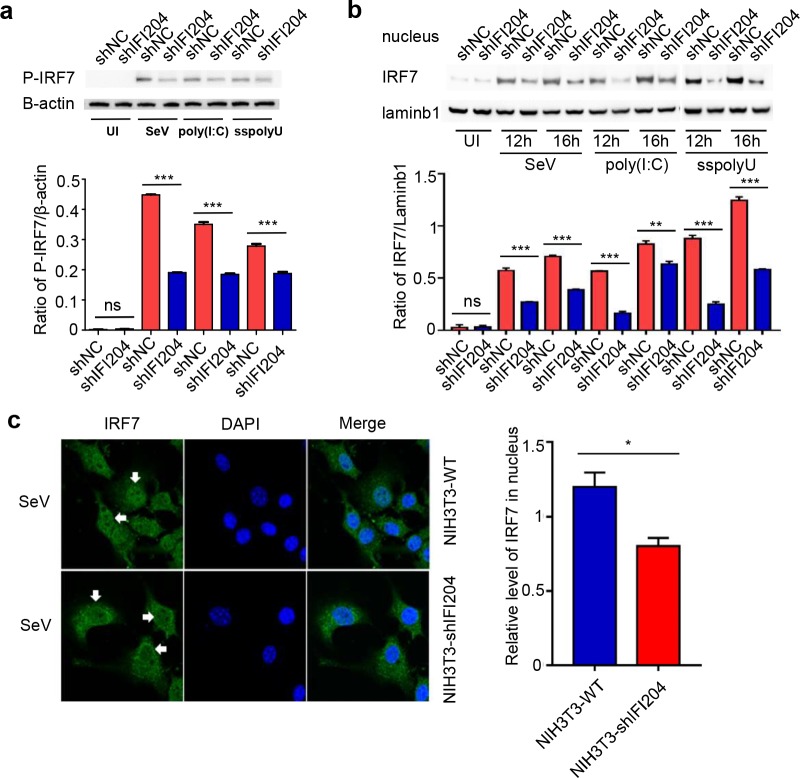
IFI204 promotes the nuclear retention of IRF7.(A) Immunoblot analysis of phosphorylation of IRF7 with rabbit mAb against phospho-IRF7-Ser437/438 (CST D6M2I) and β-actin in NIH3T3 cells infected by lentivirus-mediated shIFI204 or shNC as negative control. Cells were uninfected (UI) or infected with SeV or transfected with poly(I:C) or ssPolyU as indicated for 12 hrs. (B) Nucleo-cytoplasmic separation analysis of IRF7 in NIH3T3 cells infected by lentivirus-mediated shIFI204 or shNC as negative control. Cells were uninfected (UI) or infected with SeV or transfected with poly(I:C) or ssPolyU as indicated for 12 or 16 hrs. Nuclear lysates were tested by western blotting using anti-IRF7 and anti-lamin b1 antibodies. Levels of IRF7 was quantified by densitometry and normalized to lamin b1 protein levels. (C) Intracellular localization of endogenous IRF7 assessed by immunostaining followed by laser scanning confocal microscopy (left panel). NIH3T3 cells infected by lentivirus-mediated shIFI204 (NIH3T3-shIFI204) or shNC (NIH3T3-WT) were infected with SeV for 12 hrs. Then cells were washed with PBS and harvested for immunofluorescence analysis. Rabbit anti-IRF7 antibody was used as primary antibody and FITC-conjugated goat anti- rabbit IgG was used to detect IRF7 as shown in green fluorescence. DAPI (4, 6-diamidino-2-phenylindole) is used for nuclei staining as shown in blue fluorescence. The white arrow indicates the different protein levels of IRF7 in perinuclear region. Relative level of IRF7 in the nucleus was quantified by densitometry (right panel). *P < 0.05, **P < 0.01 and ***P < 0.001. Data are representative of two independent experiments (mean ± SD in A-C).